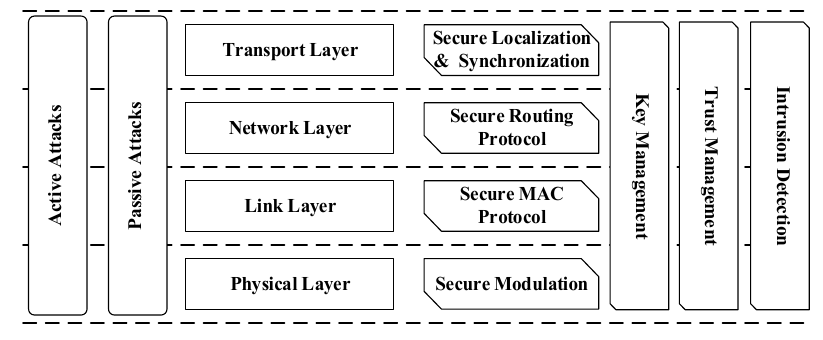
Figure 10. Security architecture of UWSNs.